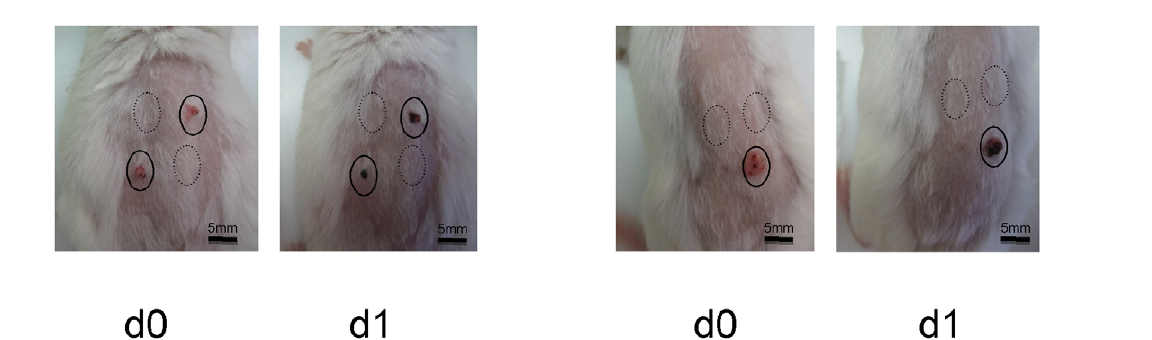
Figure 4. Visual changes over time following nsPEF exposure of induced papillomas and squamous cell carcinomas. Solid circle surround squamous cell carcinomas and dash lines surround normal skin. Appearance at 24 hours ( d1 ) post-exposure is shown following nsPEF at 200 and 400 pulses of 14 ns duration, 50 Hz and 40 kV/cm peak nominal electric field and at 200 pulses of 14ns duration, 50 Hz and 31 kV/cm peak nominal electric field. Additional images are shown on alternate days up to one week ( d3 , d5 and d7 ) for nsPEF exposure of 200 pulses of 14ns duration, 50 Hz and 40 kV/cm nominal electric field. doi:10.1371/journal.pone.0043891.g004 PLOS ONE |